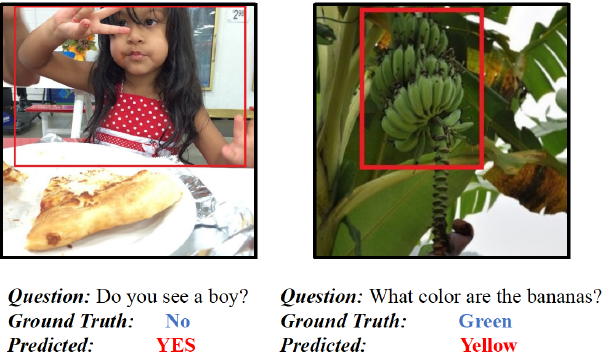
Figure 1. Example of the language bias in VQA. The output of the model is directly affected by the question. For example, the model answers ‘‘yellow” to all the questions regarding the color of the banana. If it is a yes-or-no question type, the model tends to simply answer